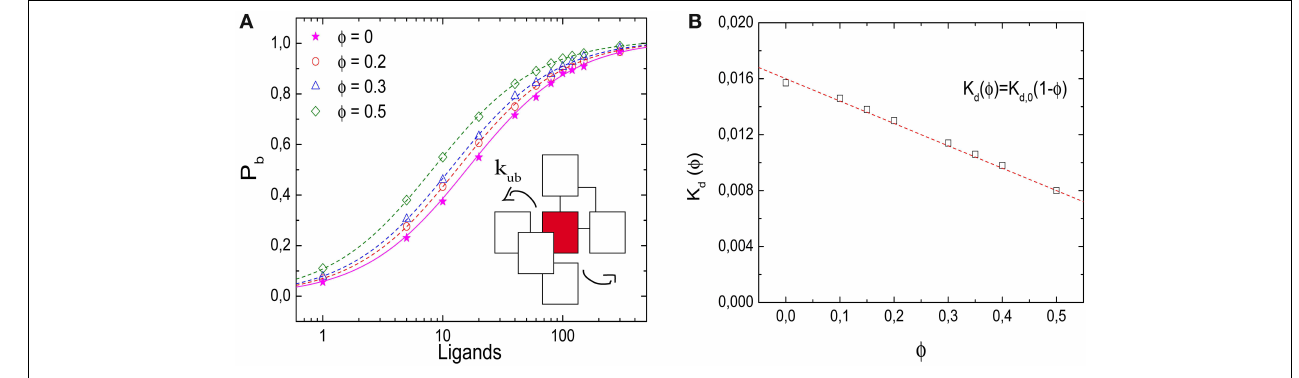
Representation of the unbinding reaction. The ligand steps from the target to one of the six nearest neighbor sites with a rate k ub . (B) Dissociation constant K d ( φ ) as a function of φ . The data points are obtained from the 0 , 0 . 2 , 0 . 3 , and = simulations by interpolation (see text) and the line is K d ( φ ) Simulation parameters: